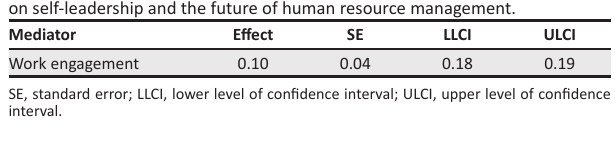
TABLE 4 : Regression results.